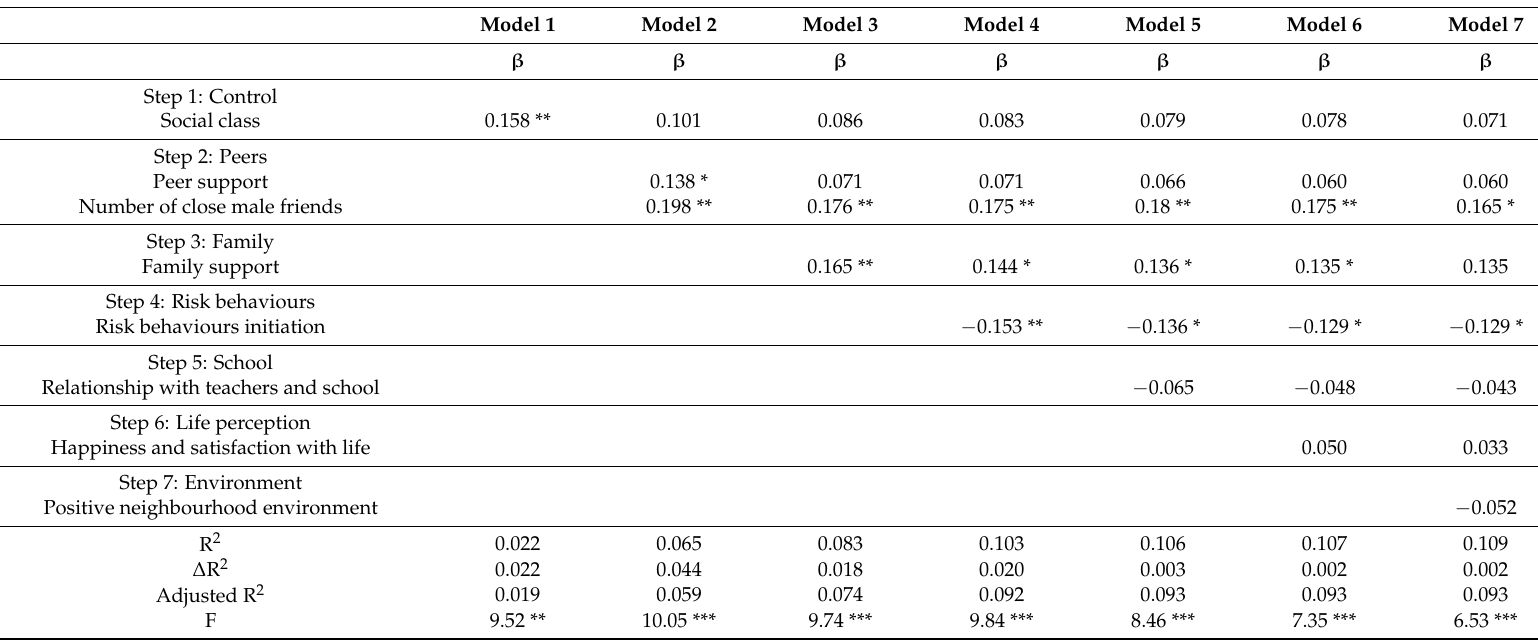
Table 2. Hierarchical linear regression model results, predictors of age of sexual initiation among